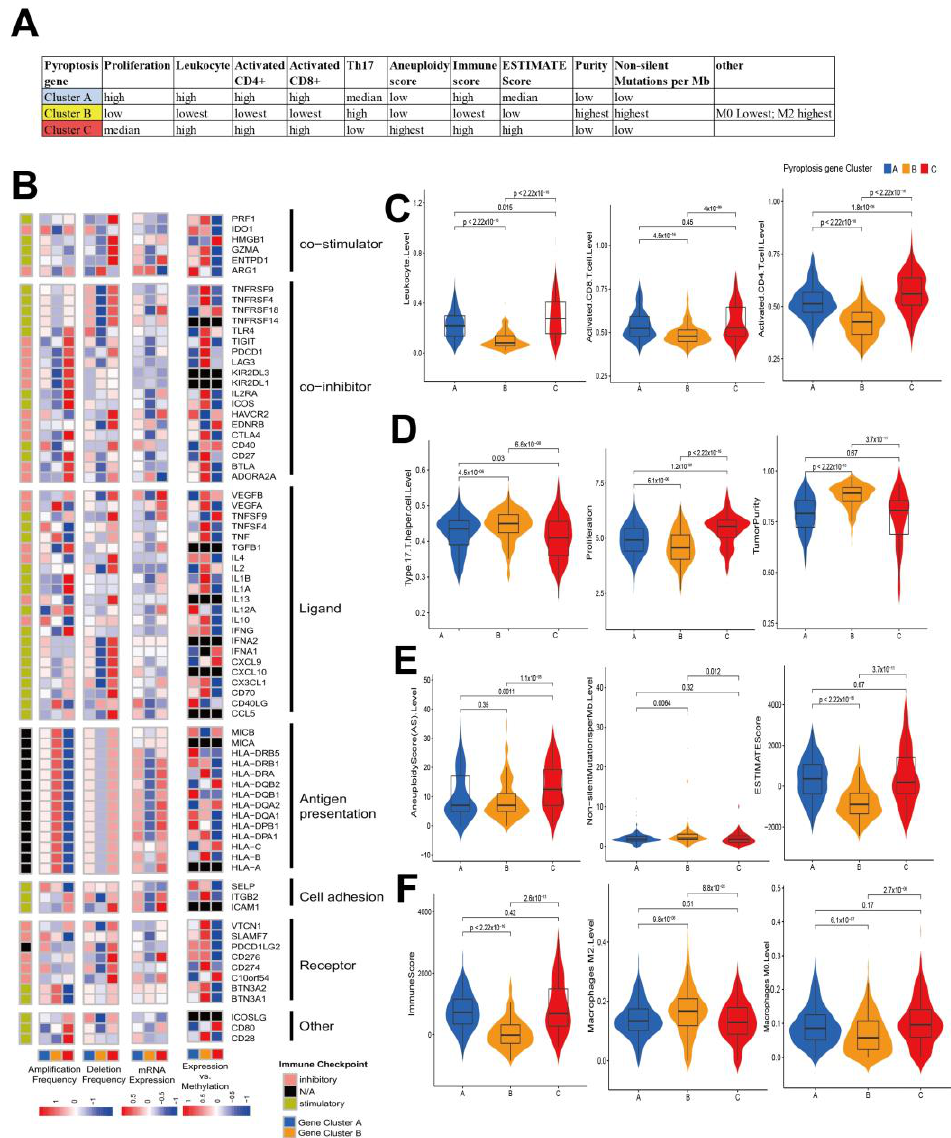
Figure 4. Immune features of three distinct clusters. ( A ) Key characteristics of pyroptosis clusters, ( B ) Regulation of immunomodulators (IMs) of three clusters, from left to right: amplification fre- quency and deletion frequency, mRNA expression (the median normalized value of each gene was selected as the representative expression of each gene cluster), and their methylation (the correlation between gene expression and DNA-methylation beta-value). The violin plot depicts the differences in key factors between the gene clusters. ( C ) Leukocytes, activated CD8+ T cells, and activated CD4+ T cells; ( D ) Th17 helper cells, proliferation, and tumor purity; ( E ) aneuploidy score, non-silent mu- tations per Mb, and ESTIMATE score; ( F ) immune score, M2 macrophages, and M0 macrophages.